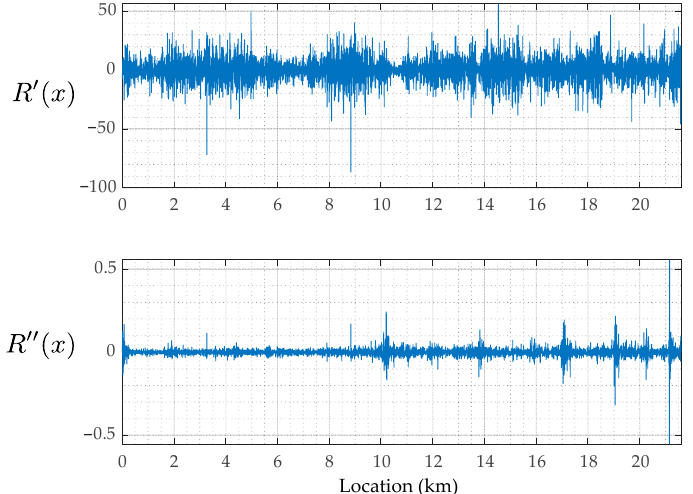
(cid:1) (cid:0) c ) = = 10 and ( k m m (cid:4673) = 10 and (cid:4672) (cid:3038) (cid:4673) = (cid:3040) (cid:3040)